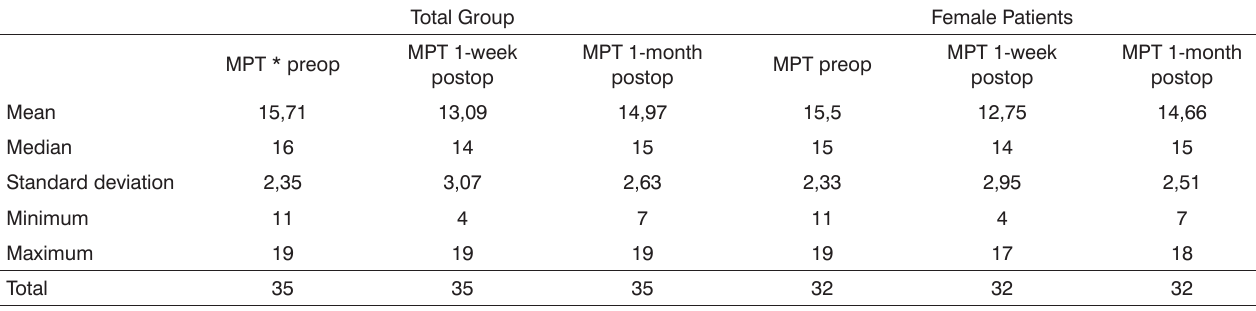
Table 1. Maximum phonation time n seconds for the group as a whole and female